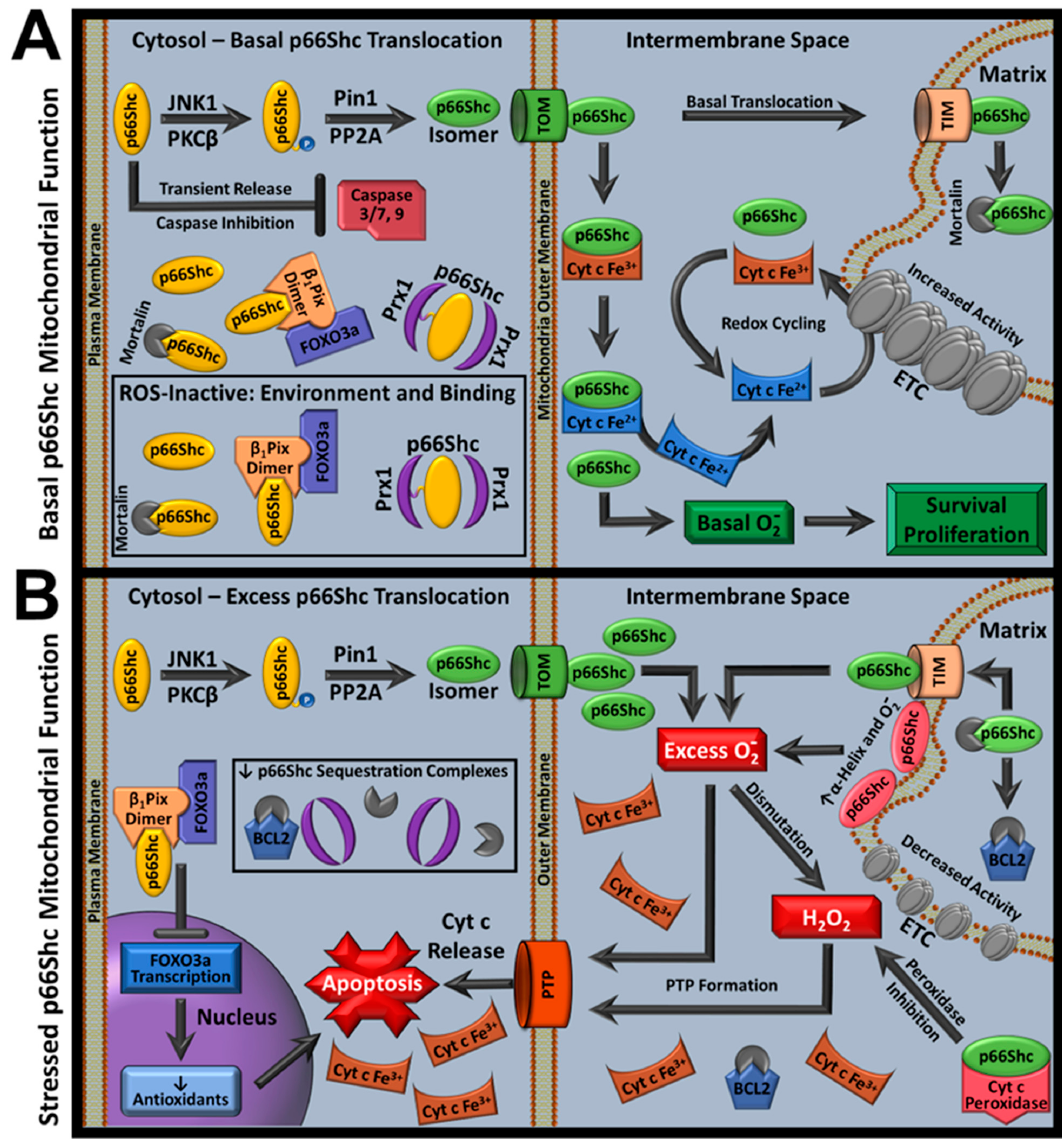
Figure 4. Revised p66Shc mitochondrial function model. ( A ) Basal p66Shc mitochondrial